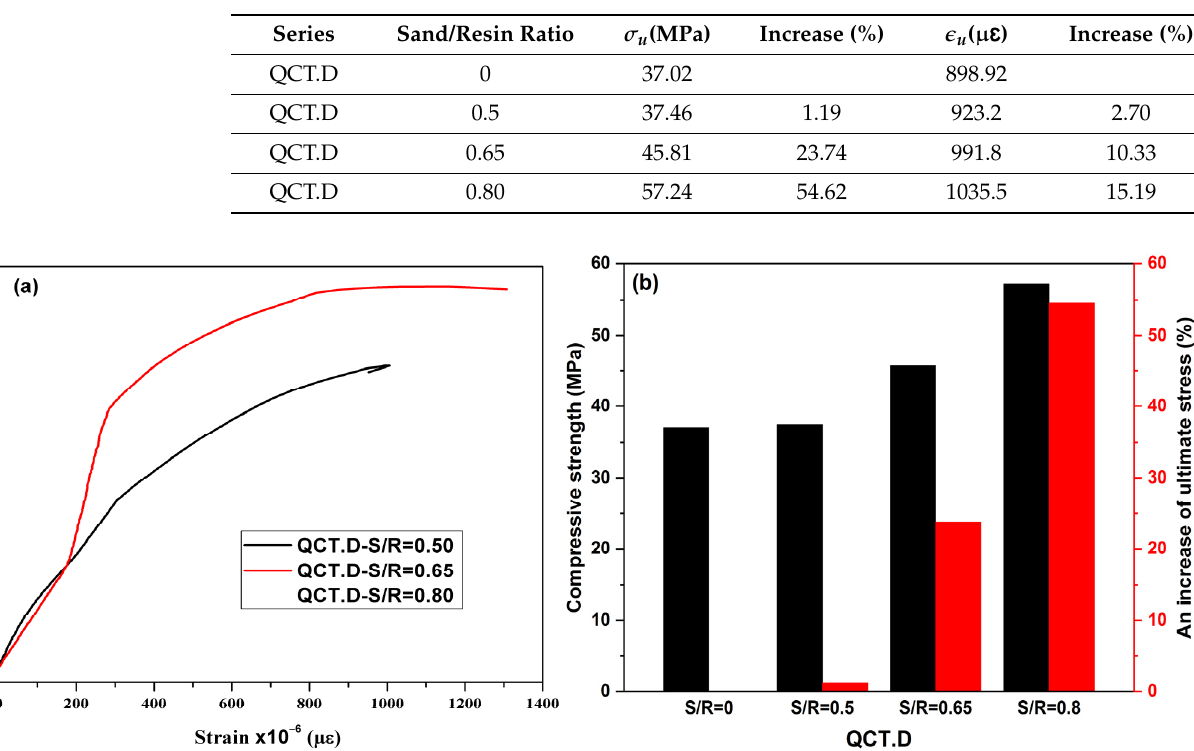
Table 12. Experimental results of compressive strength.